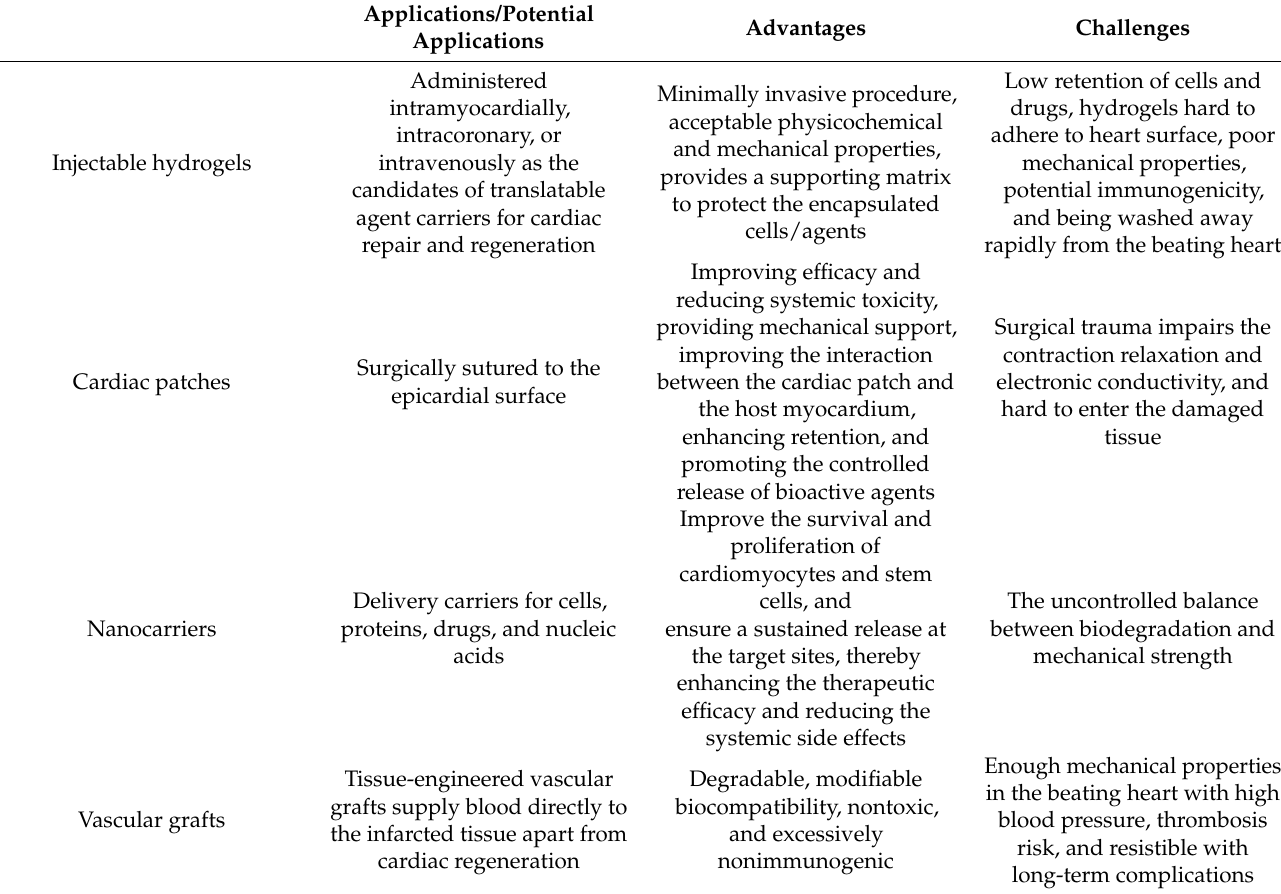
Table 2. The potential applications and the advantages and challenges of hydrogels in cardiac repair and regeneration after